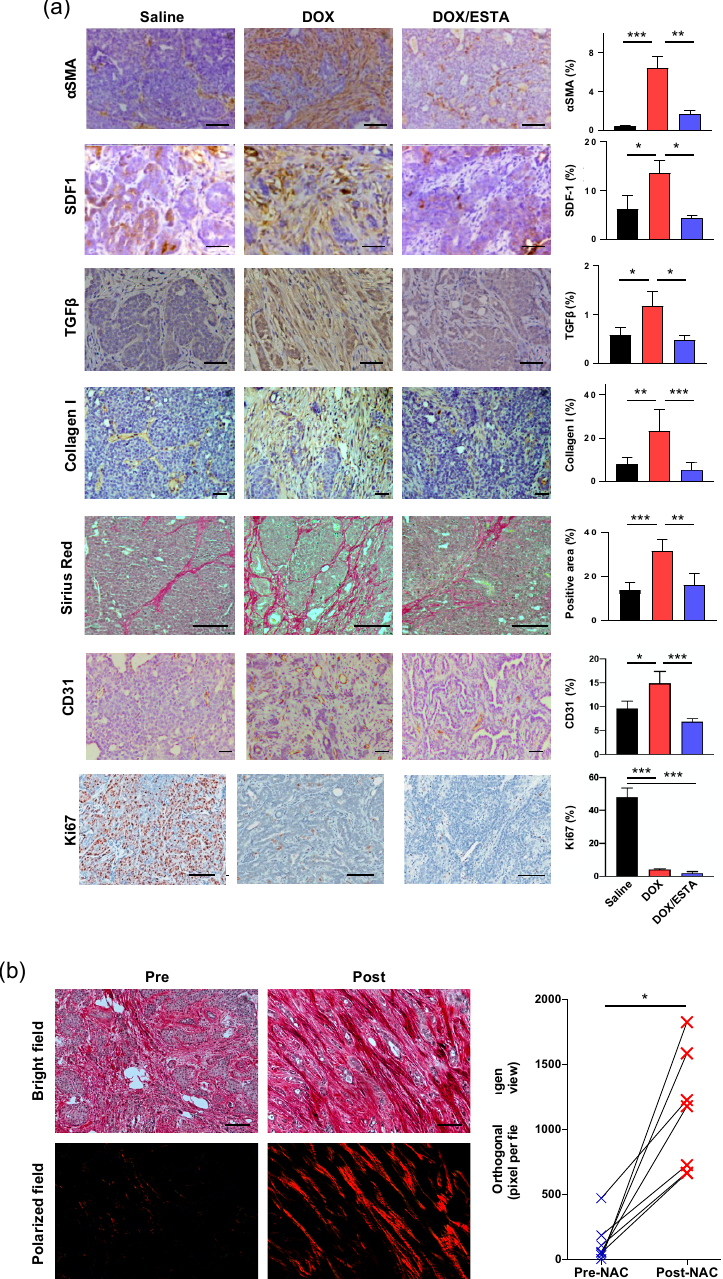
Figure 5. ESTA suppressed DOX-induced pro-tumorgenic changes. ( a ) Immunohistochemical analysis of tumor stroma components. MMTV-PyMT breast tumors ( n = 6) treated with saline, DOX, or DOX / ESTA were analyzed. Five representative images were taken from each mouse and quantified as % of stromal area (mm 2 ). Scale bar indicates 50 µ m. The data were summarized in the graph as mean ± SE. Statistical significance was analyzed by Student’s T-test. * p < 0.05; ** p < 0.01; *** p < 0.001. ( b ) Elevated collagen deposition in DOX treated surgically resected residual human breast tumors (post-treatment) and their matched biopsy tumors (pre-treatment) were stained with Picro-Sirius Red and counterstained with Weigert’s hematoxylin ( n = 7). Representative images captured by bright-field (parallel) and polarized light (orthogonal collagen) are shown. Orthogonal collagen was measured as the percentage of total unmasked pixels except perivascular in the field of view at a final magnification of × 100. Scale bar indicates 100 µ m. The graph depicted individual cases of orthogonal collagen pre- and post-treatment. Data were analyzed by the Kruskal–Wallis test, * p < 0.05, Cl =